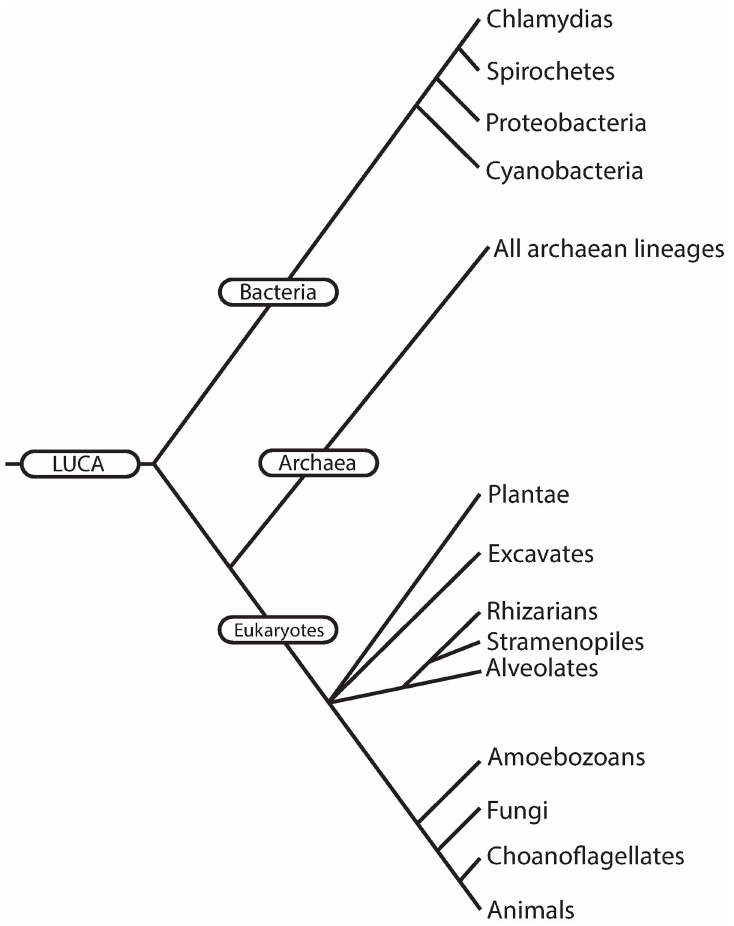
Fig 4. A “pruned” phylogenetic tree, starting at the Last UniversalCommon Ancestor(LUCA), reflects the evolutionary relationships among 17 major taxa and servesas a starting point for learning the tree of life in an introductory biology course at Cornell University (generated from